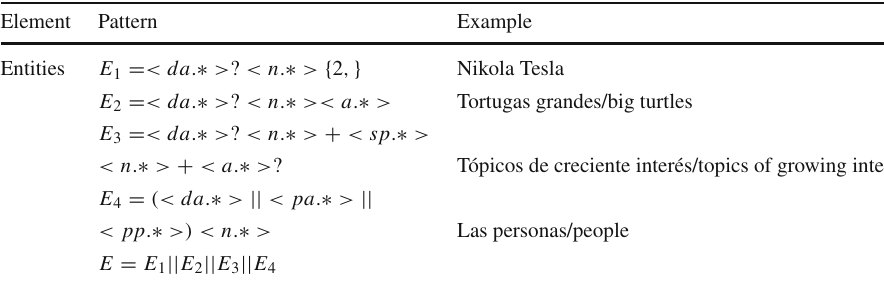
Table 1 Patterns used for the identification of entities in Spanish